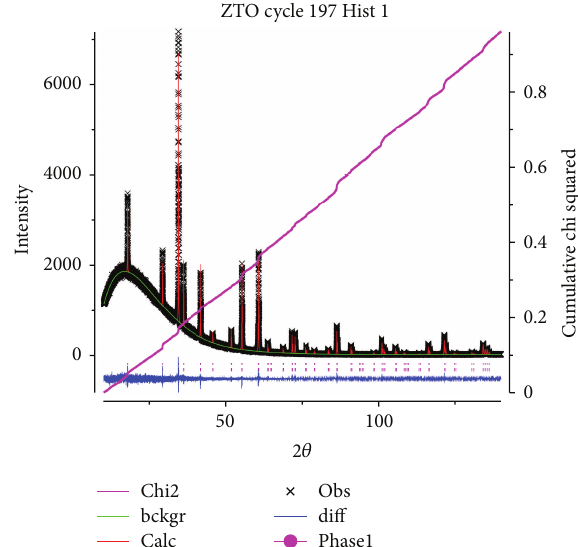
Figure 4: Rietveld refinement plot of Zn 2 SnO 4 .